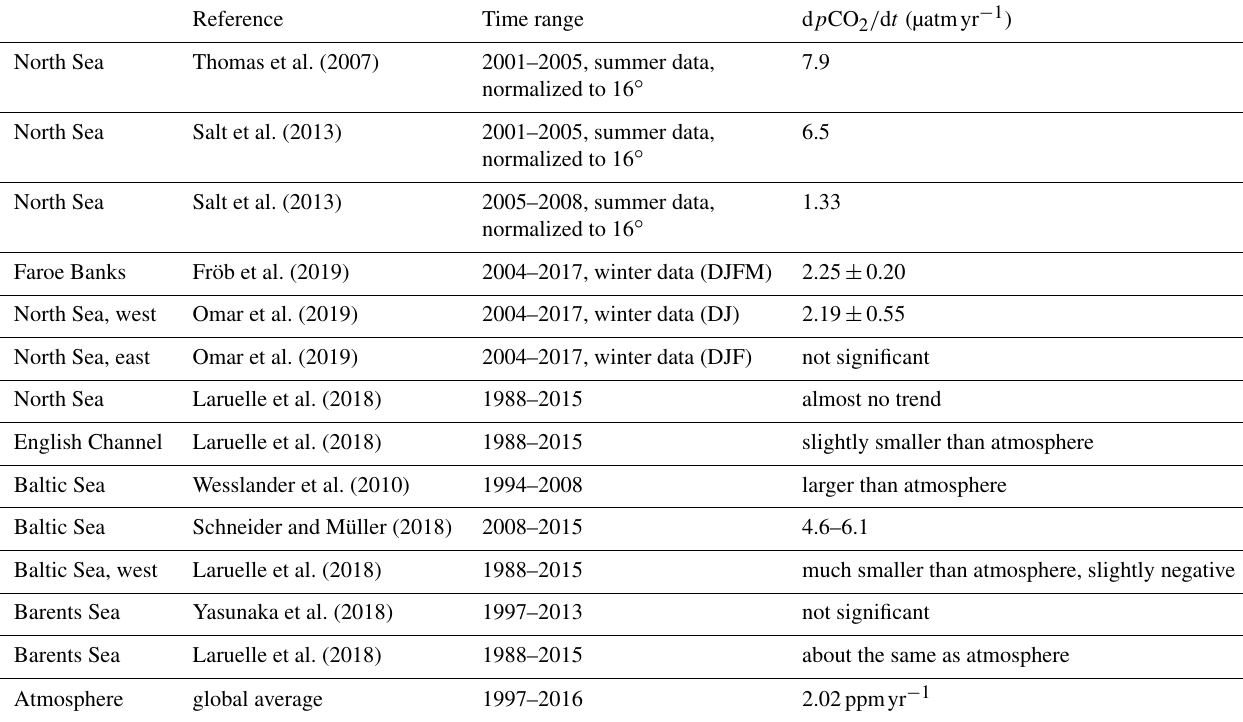
Table 1. Overview of trends in surface ocean CO 2 reported in the literature.